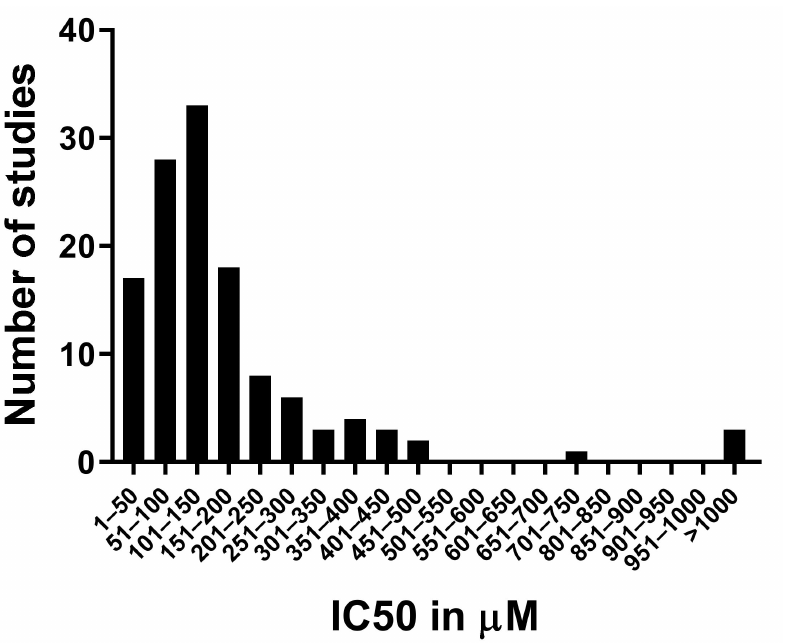
Figure 2. Distribution of the IC 50 data for cordycepin from the literature. The 50% inhibitory concentration in µ M was retrieved from 128 datasets described in 57 papers (listed in the Methods section). The number of datasets with an IC 50 in each concentration bracket indicated on the Y axis was counted and